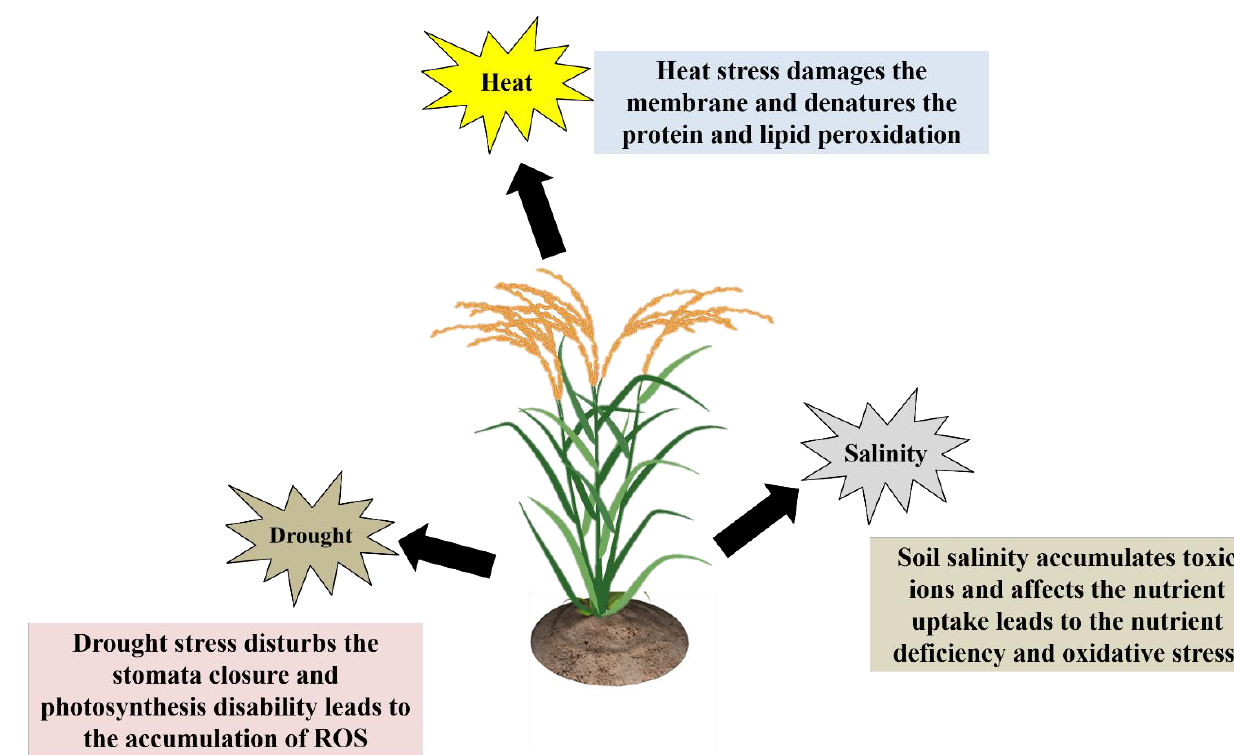
Figure 2. How do plants react to environmental stress